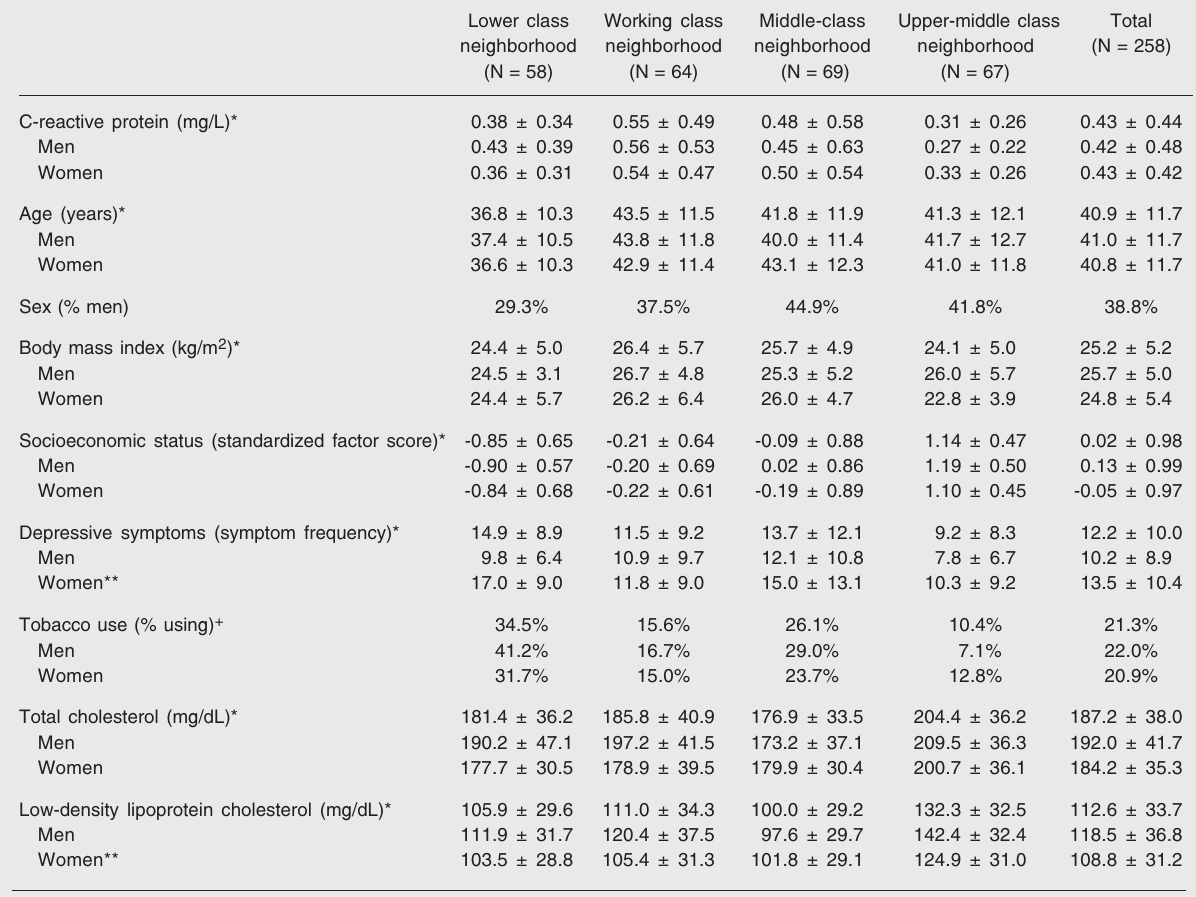
Table 1. Descriptive statistics of the population